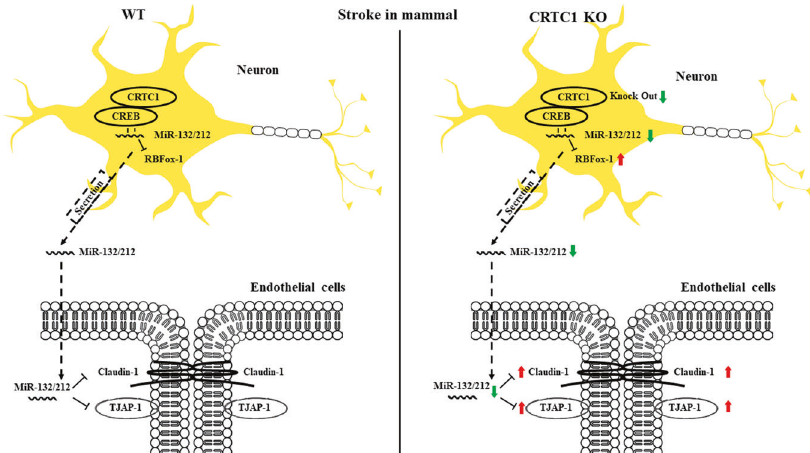
Fig. 8 Graphic abstract. CRTC1-mediated miR-132/212 attenuates neuron damages via suppressing RBFox-1, and alleviates blood – brain barrier dysfunction by regulating TJAP-1 and Claudin-1 expression in ischemic